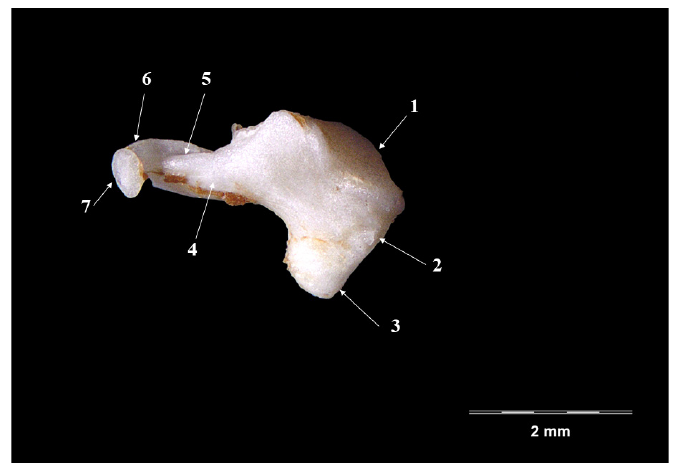
Figure 3. Incus-medial perspective 1. Incundomalearis articular surface, 2. Corpus incundis; 3. Crus breve; 4. Crus longum; 5. Junction point- crus-blade; 6. Bony blade; 7. Processus lenticularis.